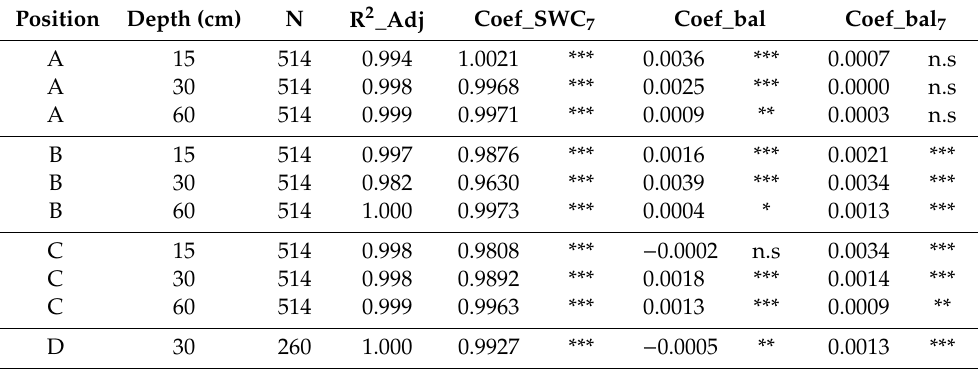
Table 3. Summary of dependence of soil water content (SWC) measured by sensors on the measurement of a week before (Coef_SWC 7 ), the water input / output balance of the day (Coef_bal) and on the water input / output balance of the whole previous week (Coef_bal 7 ). N corresponds to the number of SWC